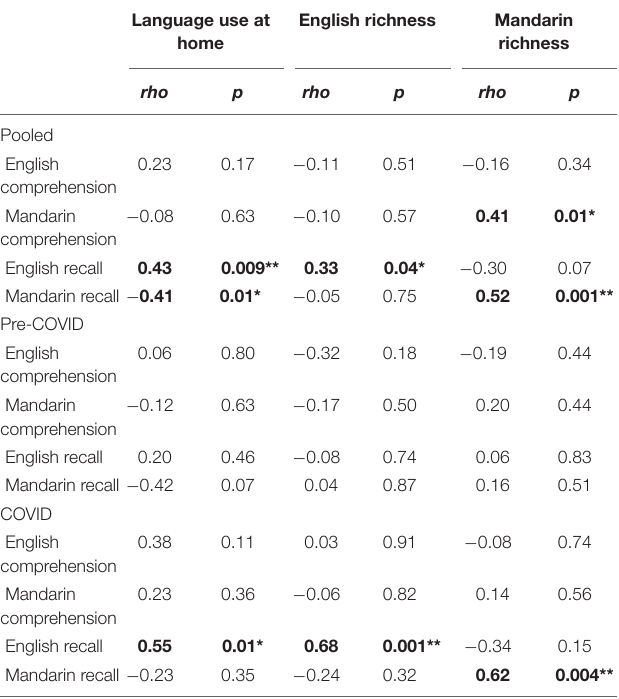
TABLE 2 | Summary of Spearman’s rank order correlation matrix between language use and language performance